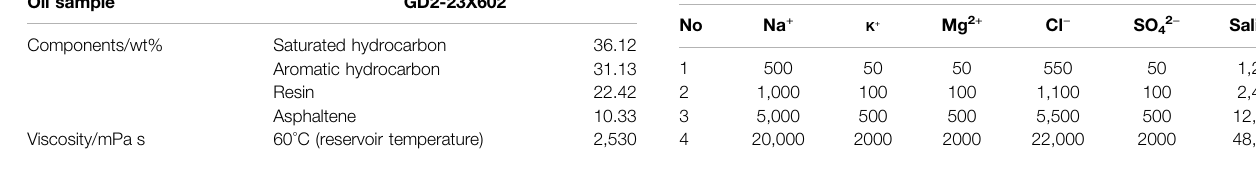
TABLE 2 | Composition of Na + solution